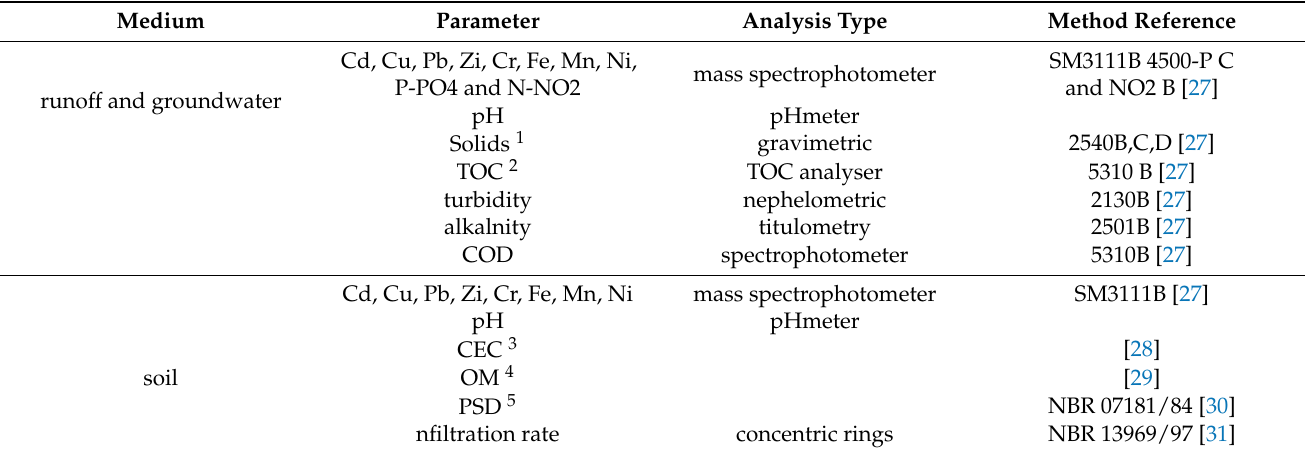
Table 1. Analytical methods applied to water and soil samples.